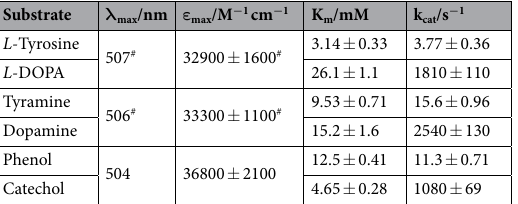
Table 2. Kinetic parameters of activated Ab PPO4. # Values taken from 70 ; The entries are given as value ± standard